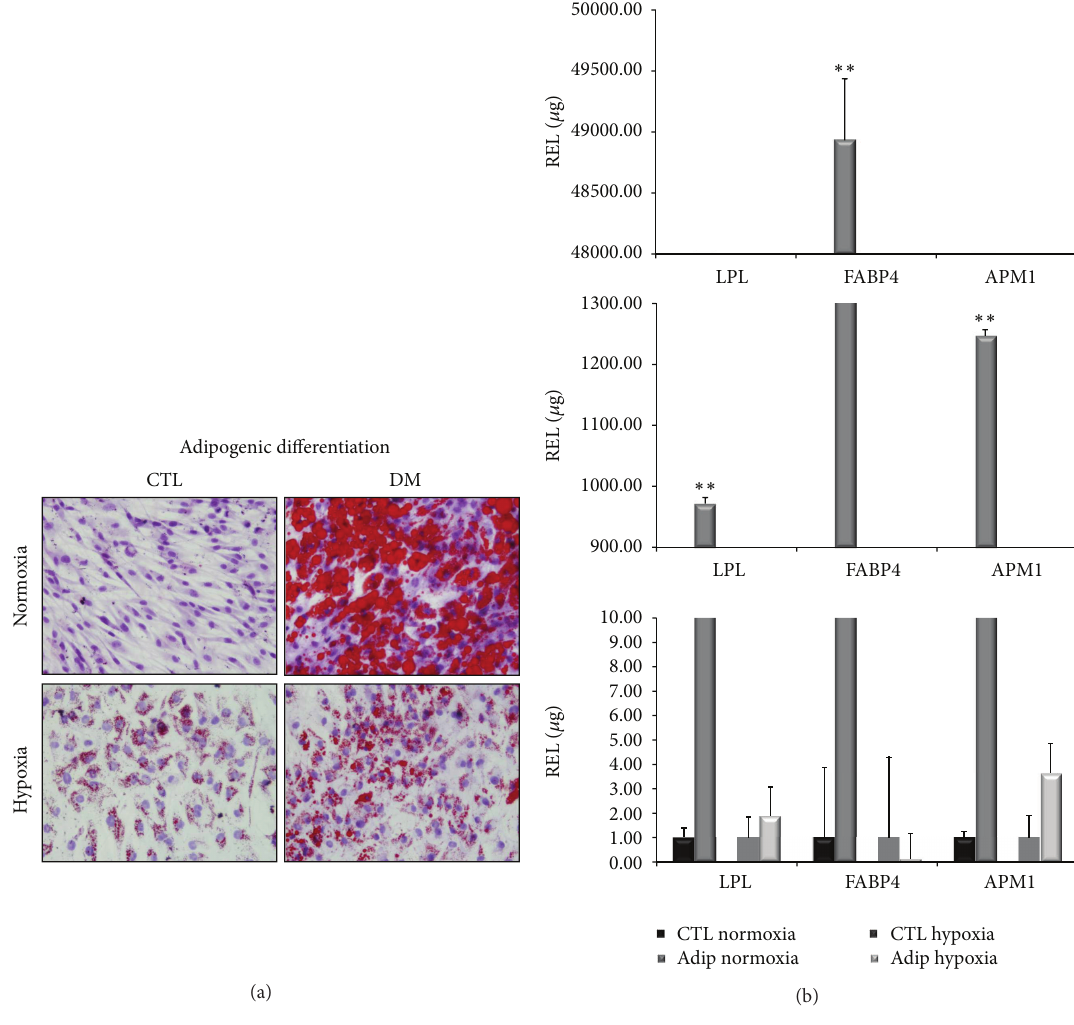
Figure 2: Staining techniques of adipogenic differentiated cells and adipogenic-specific gene expression levels in normoxic and hypoxic conditions. (a) Oil red O staining of the cells differentiated (DM) compared to their control point (CTL). The photos are relative to day 21 of cultures in normoxic and hypoxic conditions. (b) We compared CTL and treated cells (Adip.). Expression levels of LPL, FABP4, and APM1 at day 21 of cultures in normoxic ( ∗∗ 𝑃 < 0.005 ) and hypoxic